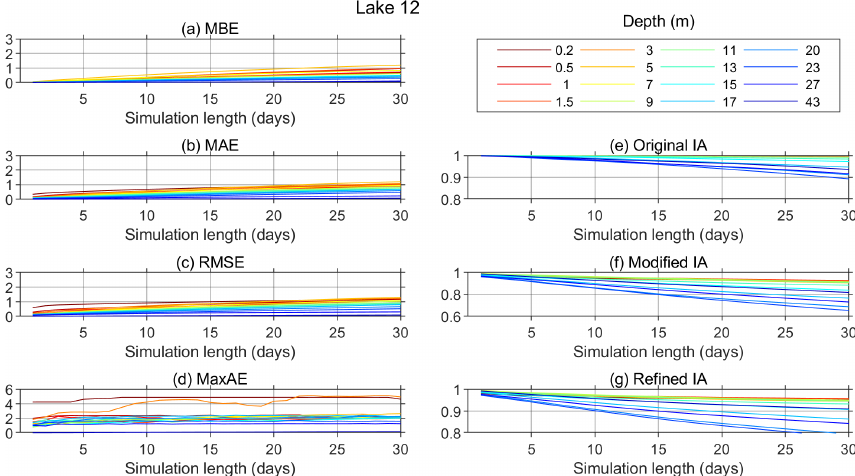
Figure 10. Model performance parameters for Lake 12 (calculated for all the periods with necessary data available: 7 July–4 November 2018;